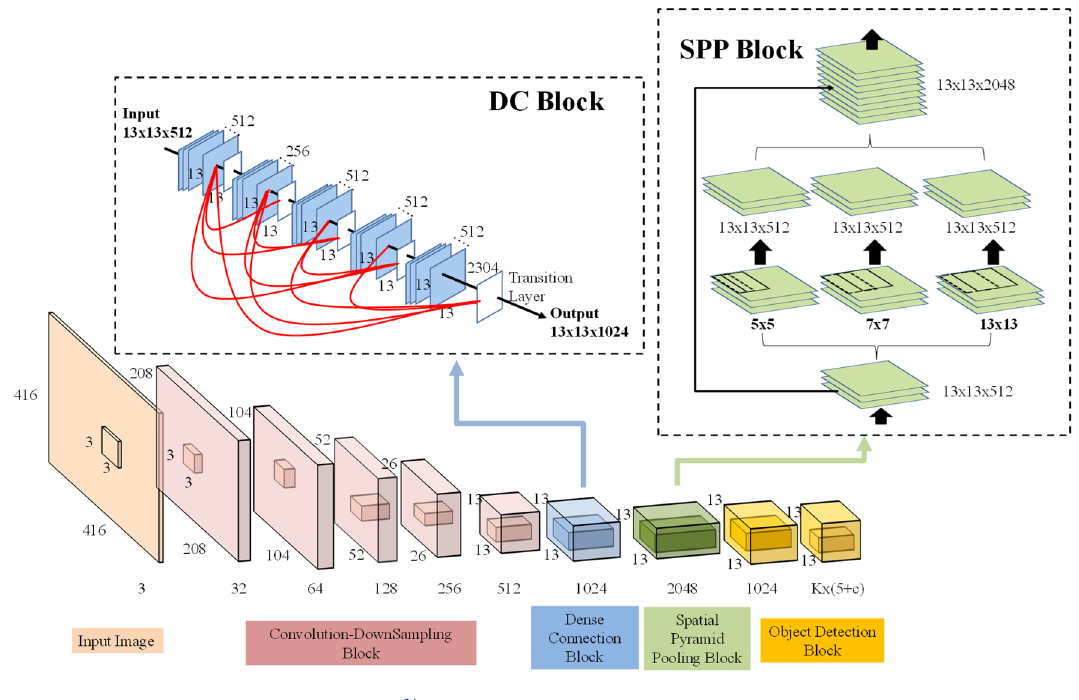
Figure 2. The structure of YOLO v4 34